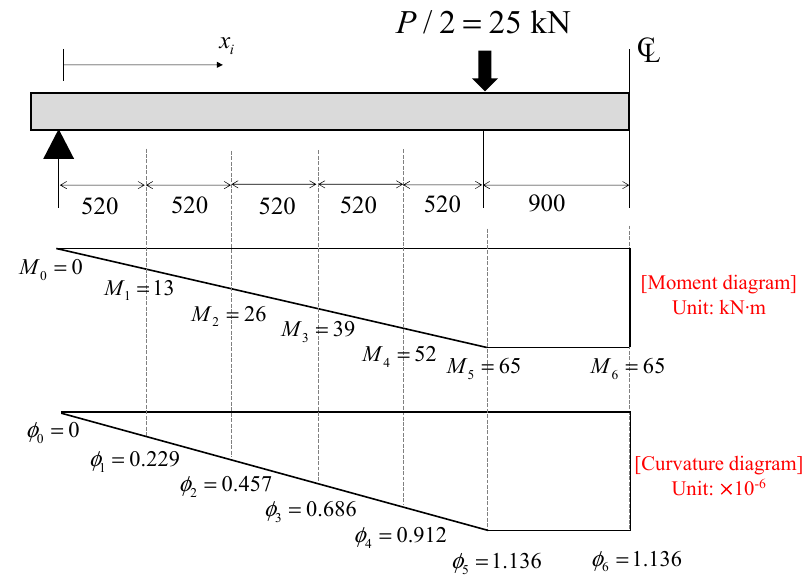
Figure A5. Moment and curvature distributions.